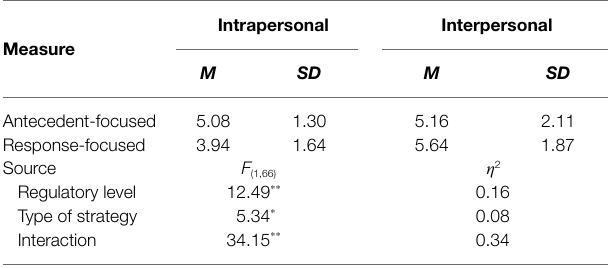
TABLE 3 | Means, standard deviations, and analyses of variance in regulatory levels and types of